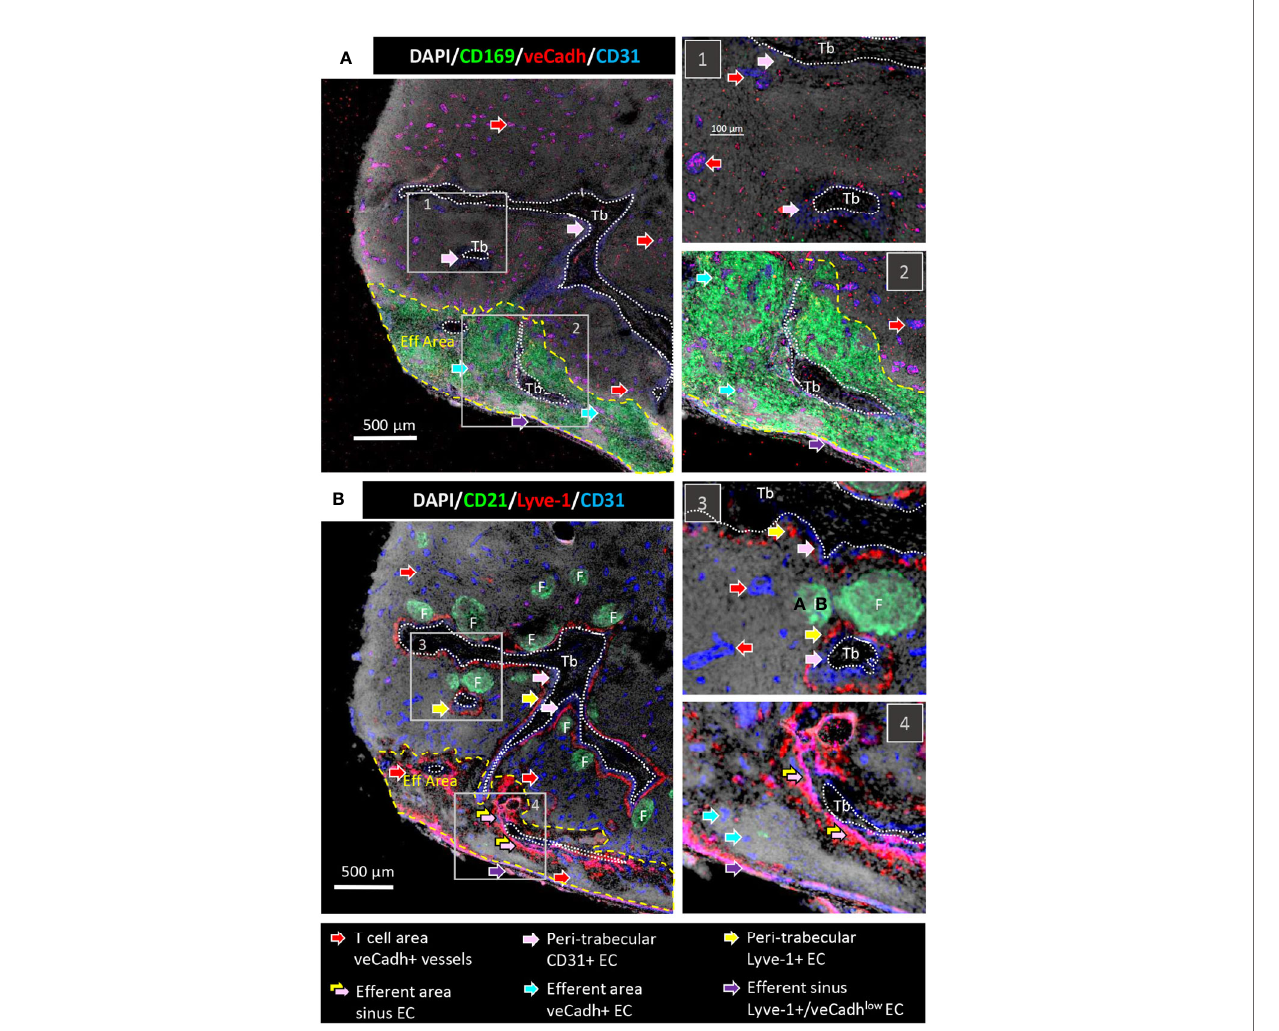
FIGURE 2 | LN vessels and sinuses are delimited by endothelial cells expressing different levels of CD31, veCadherin and Lyve-1. Consecutive 10 µm thick sections from the same LN as in Figure 1 were stained with (A) anti-CD169, anti-veCadherin, anti-CD31 antibodies and DAPI or (B) anti-CD21, anti-Lyve-1, anti-CD31 antibodies and DAPI. Tb, Trabeculae; Eff Area, efferent area. F: B cell Follicle. Red arrows: T cell area veCadherin pos vessels, pink arrows: Trabecular CD31 pos endothelial cells, yellow arrows: Trabecular Lyve-1 pos endothelial cells, double pink/yellow arrows: efferent area sinus endothelial cells, blue arrows: efferent area veCadherin pos vessels, violet arrows: efferent sinus Lyve-1 pos /veCadherin pos endothelial cells. The right pictures numbered 1 and 2 in A) and 3 and 4 in B) referred to enlargements of the framed regions 1 to 4 on the left large pictures. Whole LN pictures are individual images from 10x objective acquisitions, scale bar 500 µm. Images are representative of 3 LN from different